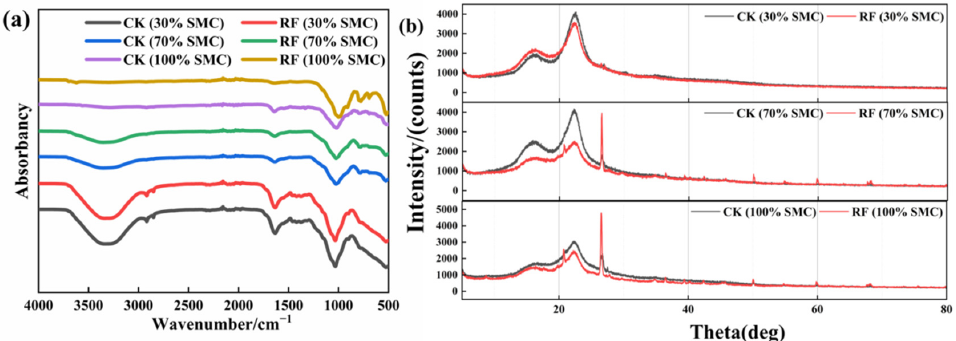
Figure 3. FTIR and XRD observations of straw materials from control samples and after RF application at different SMCs (30%, 70%, and 100%). ( a ) FTIR observations. ( b ) XRD observations.